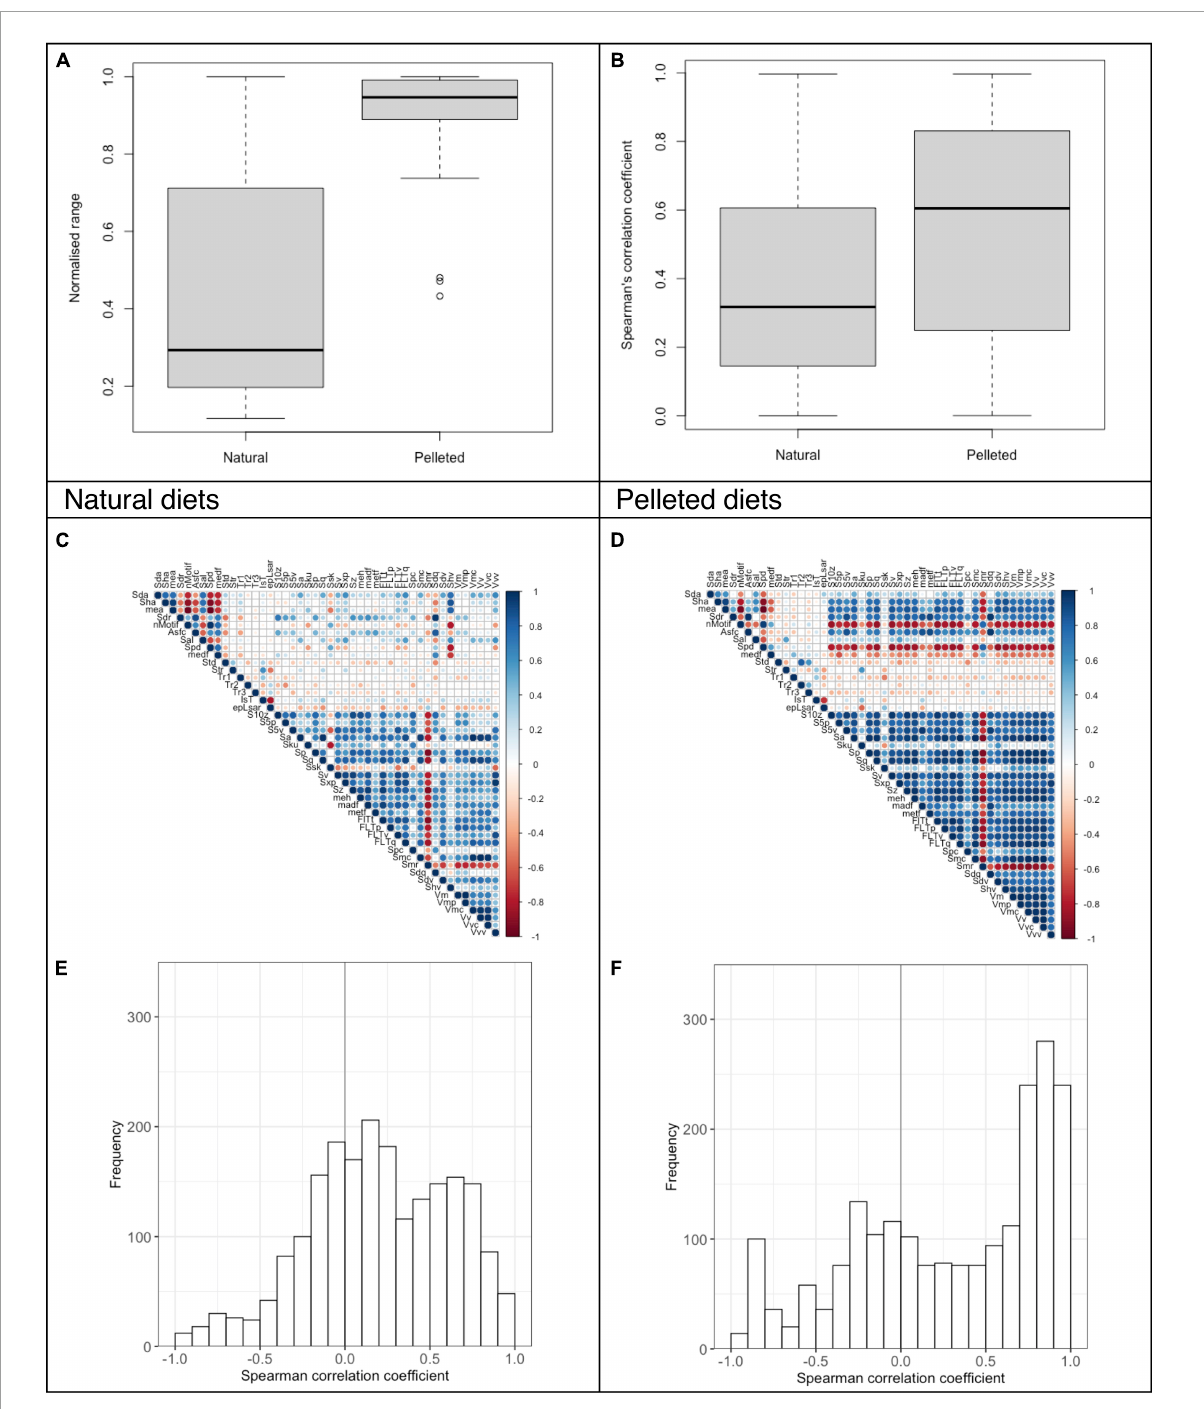
FIGURE2 Analysis of DMT parameters for guinea pigs fed a lucerne diet either as whole plant hay or as a pelleted diet for P4 to M3 (dataset C). The data is presented as a summary for all teeth (24 scans for natural diet, 22 scans for pelleted diet. For two animals on the pelleted diet M3 could not be measured). The normalized data range and the Spearman’s correlation coefficients are given as boxplots (A,B) . The Spearman’s correlation of the DMT parameters is also shown as a correlation matrix (C,D) and a histogram (E,F)